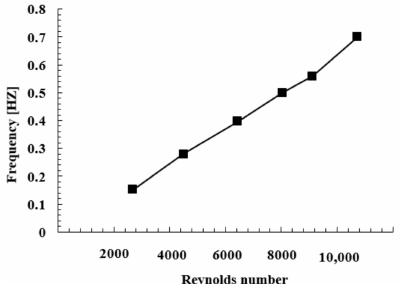
Figure 5. Frequency versus Reynolds number for free external domain (the uncertainty was estimated at around 2%